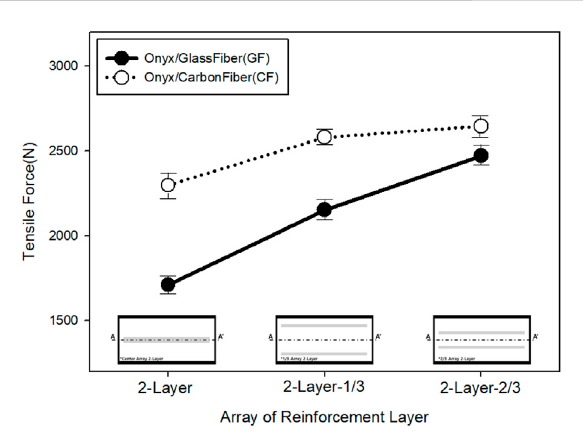
FIGURE 6 Tensile force according to the position of 2-layer reinforcement.